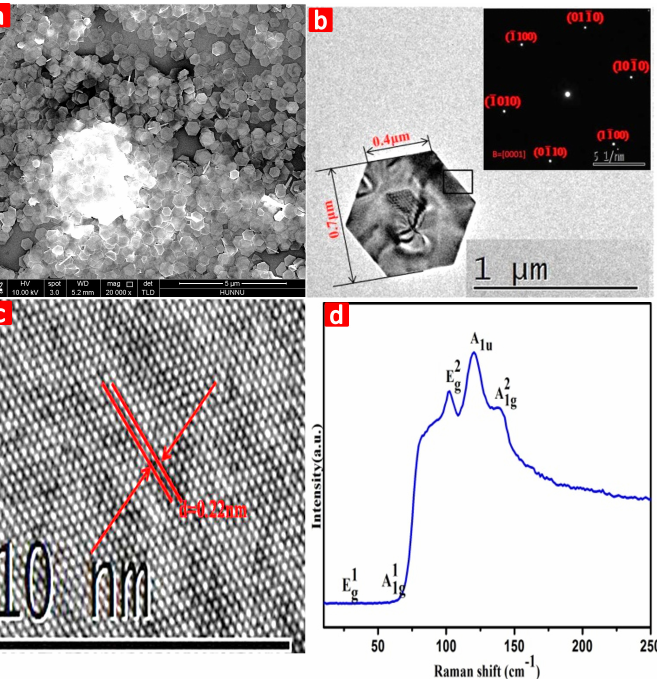
Figure 2. ( a ) SEM image. ( b ) Low magnification TEM image and SAED pattern. ( c ) HRTEM image. ( d ) Raman spectrum at room temperature of single Bi 2 Te 3